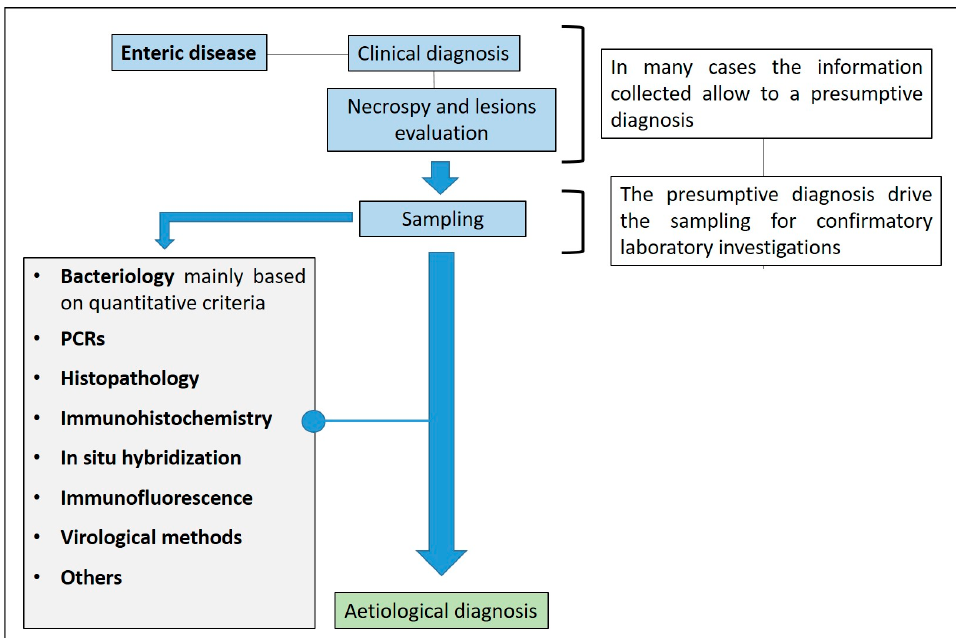
Figure 1. Enteric disease and diagnostic